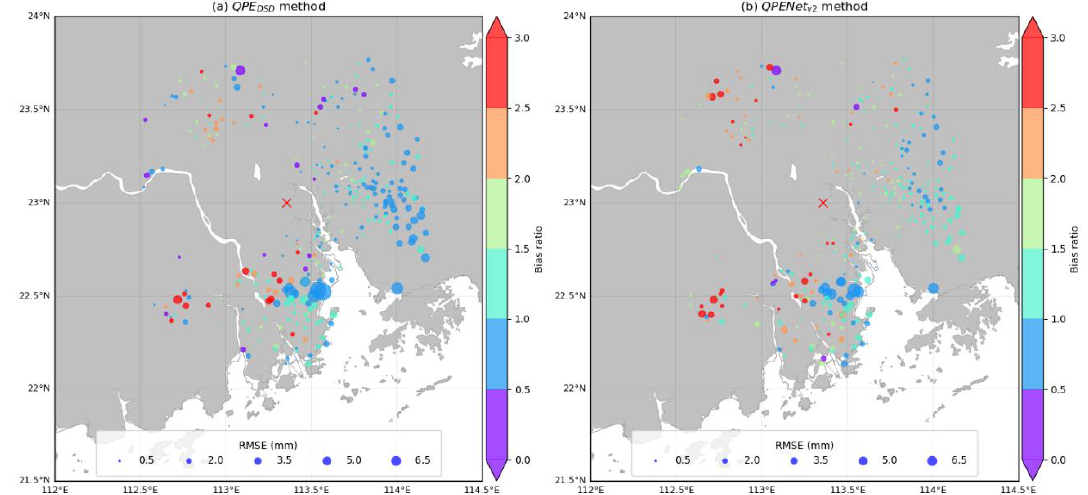
Figure 11. The spatial distributions of the bias ratios and RMSEs of hourly rainfall estimates from ( a ) QPE DSD and ( b ) QPENet V2 during typhoon Merbok. The bias ratios and RMSEs were calculated based on the automatic weather station observations. The red cross represents the location of the Guangzhou radar. The size of the dots represents the RMSE, the color of the dots indicates the bias ratio.